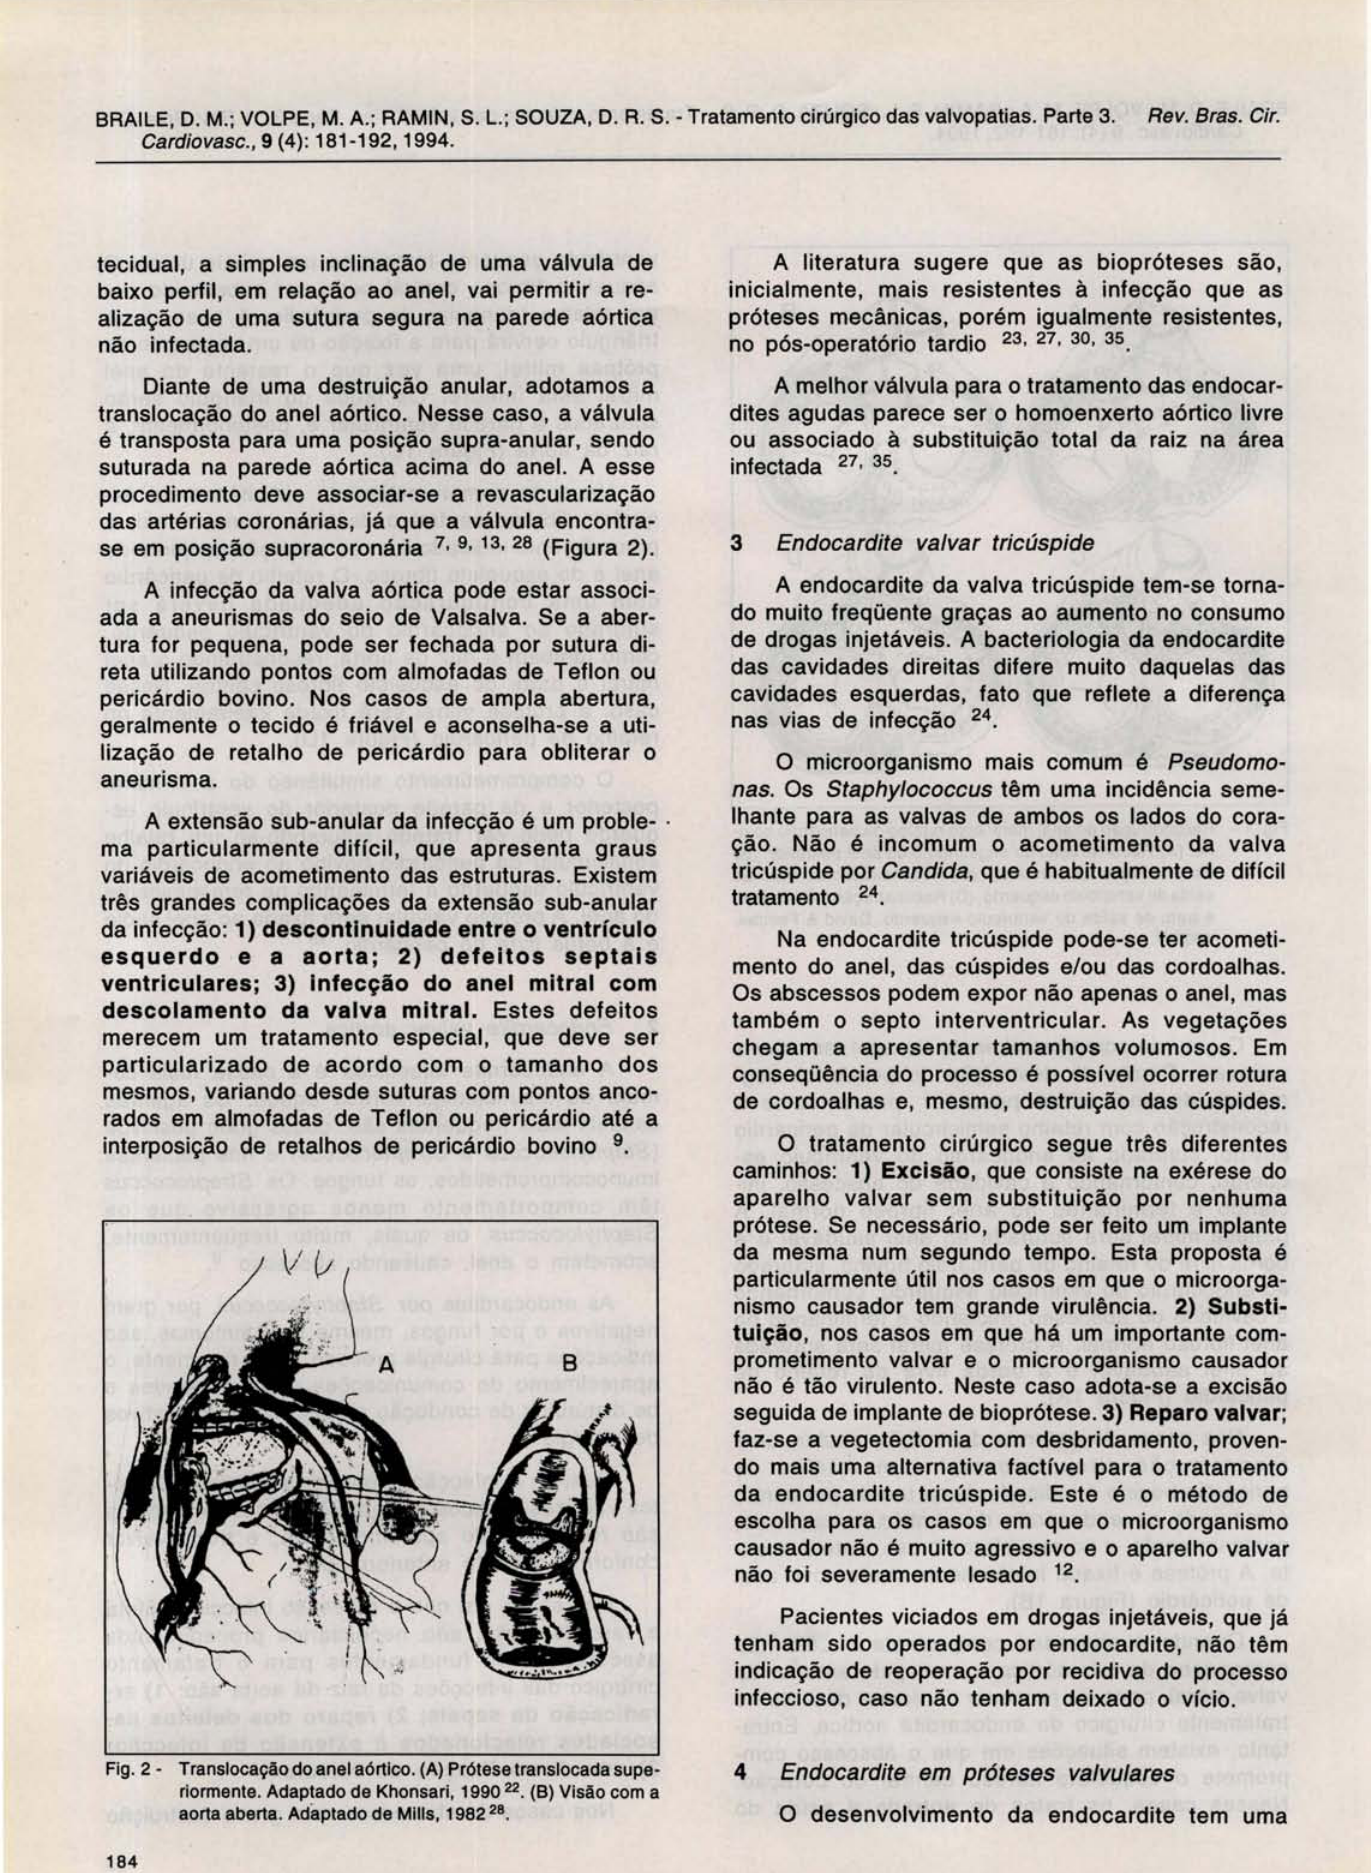
Fig. 2· Translocação do anel aórtico. (A) Prótese translocada supe riormente. Adaptado de Khonsari, 1990 22 . (6) Visão com a aorta aberta. Adaptado de Mills, 1982